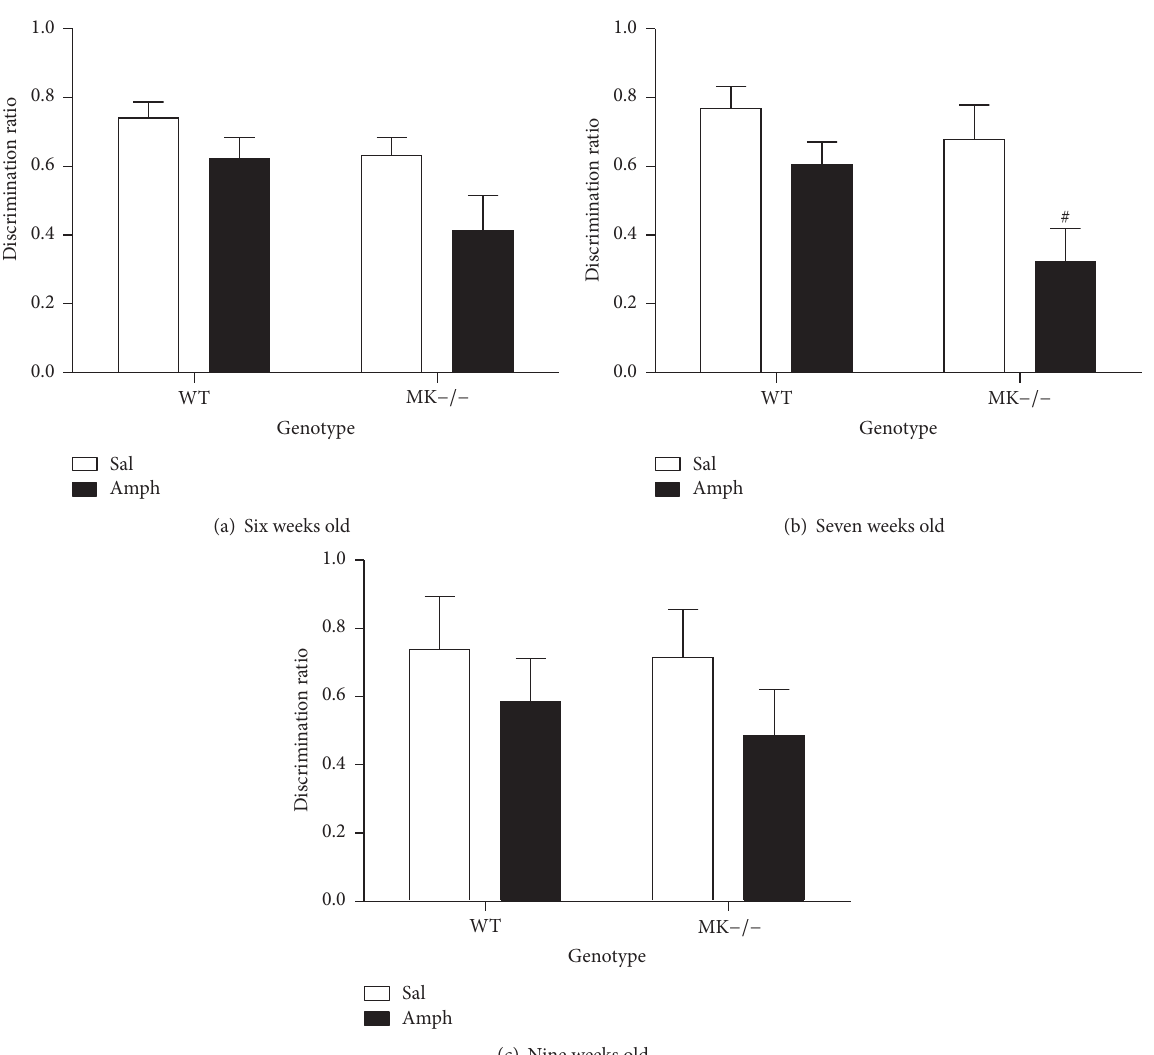
Figure 6: Behavioral performance in the Y-maze of WT and MK − / − mice treated with amphetamine during adolescence. (a) Figure shows mean ± SEM of discrimination ratio for 6-week-old WT and MK − / − mice pretreated with amphetamine during adolescence. Significant effects of the genotype ( F (1,44) = 5.04, 𝑃 = 0.03 ) and the treatment ( F (1,44) = 6.03, 𝑃 = 0.02 ) were found. (b) Figure shows mean ± SEM of discrimination ratio for 7-week-old WT and MK − / − mice pretreated with amphetamine. Significant effects of the genotype ( F (1,44) = 5.1, 𝑃 = 0.002 ) were found. (c) Figure shows mean ± SEM of discrimination ratio for 9-week-old WT 𝑃 = 0.03 ) and treatment ( F (1,44) = 10.46, and MK − / − mice pretreated with amphetamine. # 𝑃 < 0.05 versus